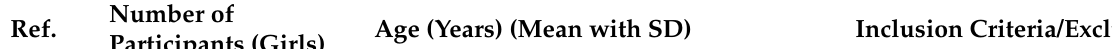
Table 3. The characteristics of the subjects of the included intervention